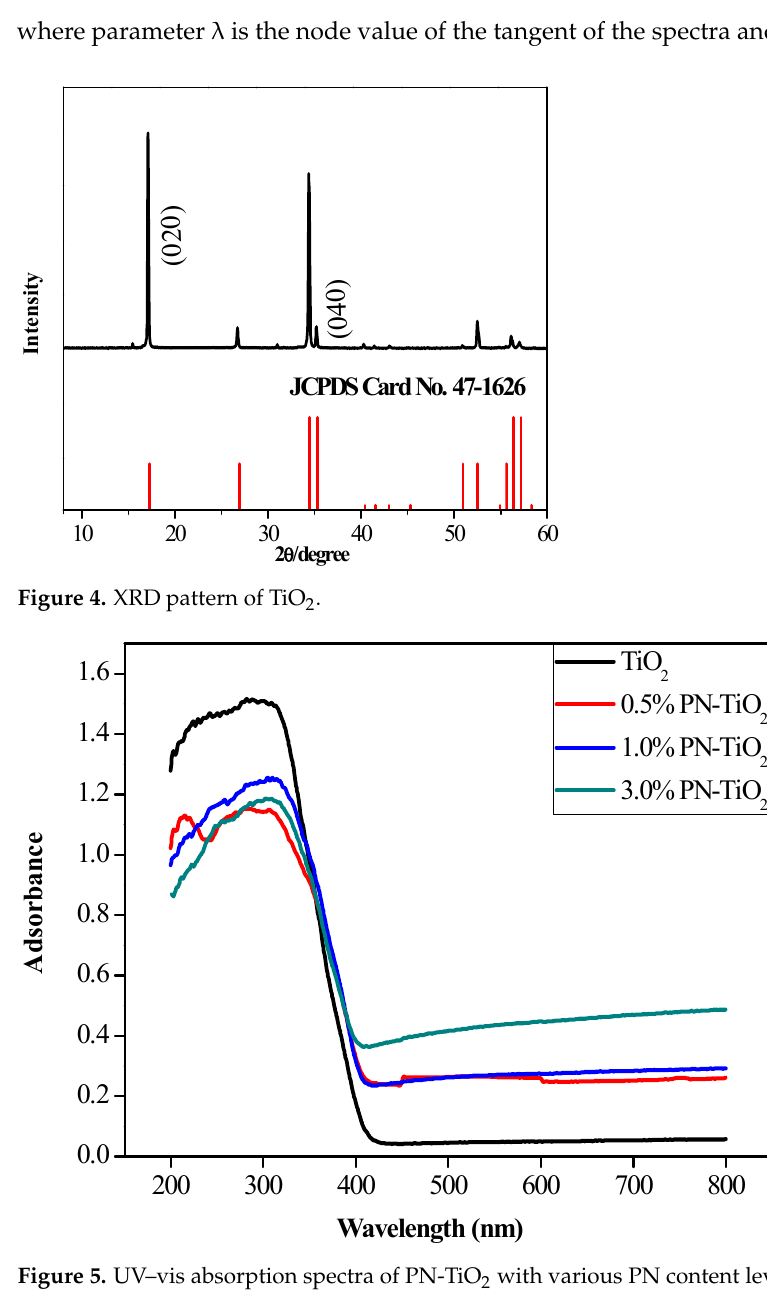
Figure 5. UV–vis absorption spectra of PN-TiO 2 with various PN content levels.